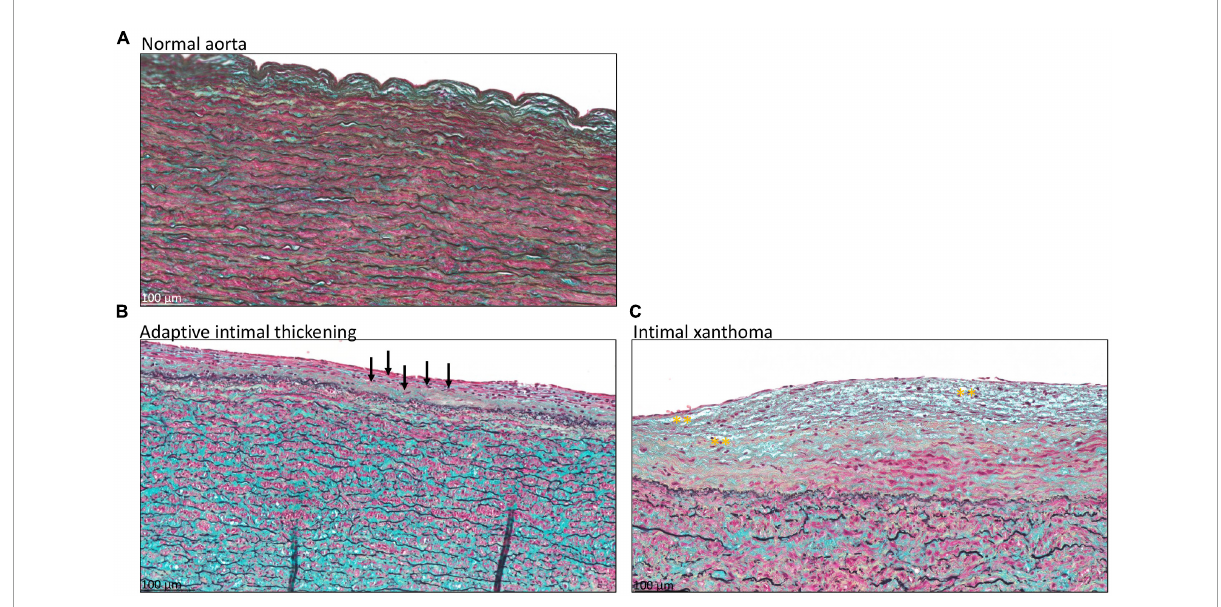
FIGURE2 Transverse histologic section of type A aortic dissection aortic specimen (4 µ m), stained with MOVAT pentachrome. (A) Shows a normal intimal layer, without any signs of adaptive or pathological thinning. In panel (B) an adaptive thickened intima is seen with mainly vascular smooth muscle cells in the proteoglycan-rich matrix, a few of which are depicted with black arrows. (C) Intimal xanthoma is seen in a patient with macrophage derived foam cells in the matrix, highlighted with yellow asterisks. Scale bar shown in the